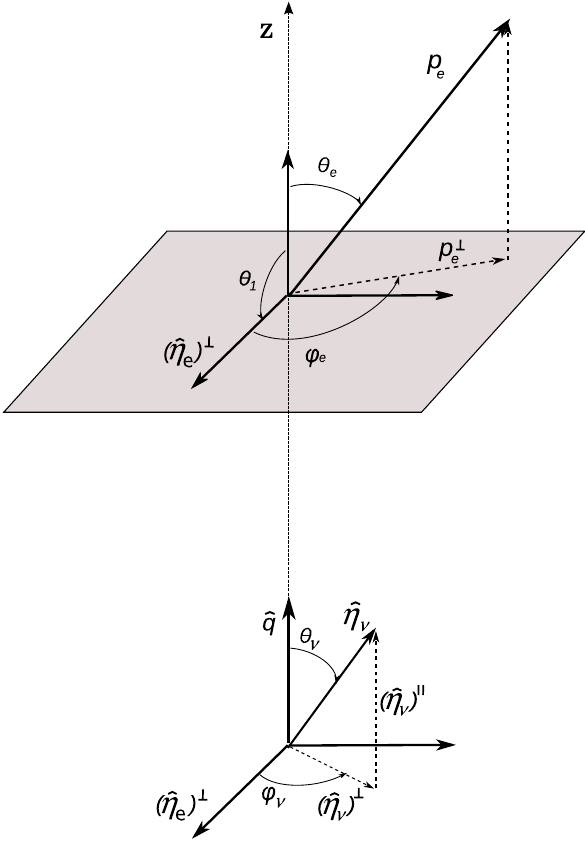
Fig. 1 The reaction plane is spanned by the ν e LAB momentum unit vector ˆ q and the electron polarization vector of the target ˆ η e . θ 1 is the angle between ˆ η e and ˆ q (on the plot θ 1 = π/ 2 so in this case ˆ q and the unit vector ˆ p ˆ η = ˆ η ) ⊥ ). θ e e e is the polar angle between e of the recoil electron momentum. φ e is the angle between ˆ η e ) ⊥ and the transversal component of outgoing electron momentum ( ˆ p e ) ⊥ . φ ν and θ ν are the azimuthal and the polar angles of the unit polarization vector of the incoming neutrino, ˆ η ν = ( sin θ ν cos φ ν , sin θ ν sin φ ν , cos θ ν )